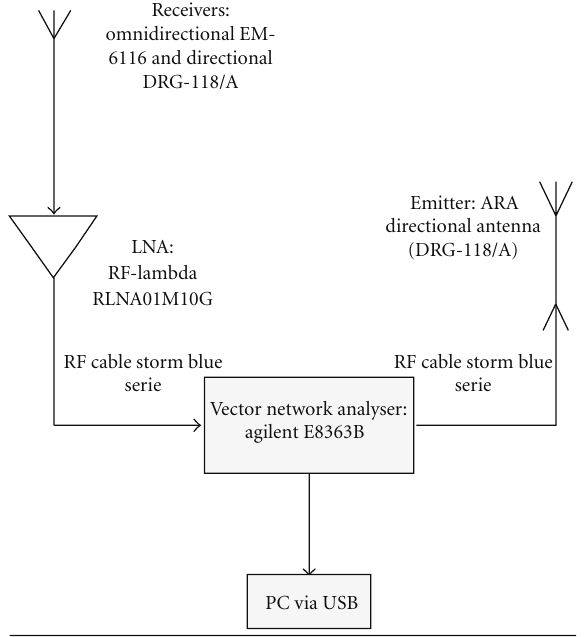
Figure 3: Schematic of the experimental protocol. is no movement in the surrounding environment. To ensure alignment, a laser was used to maintain the same level.